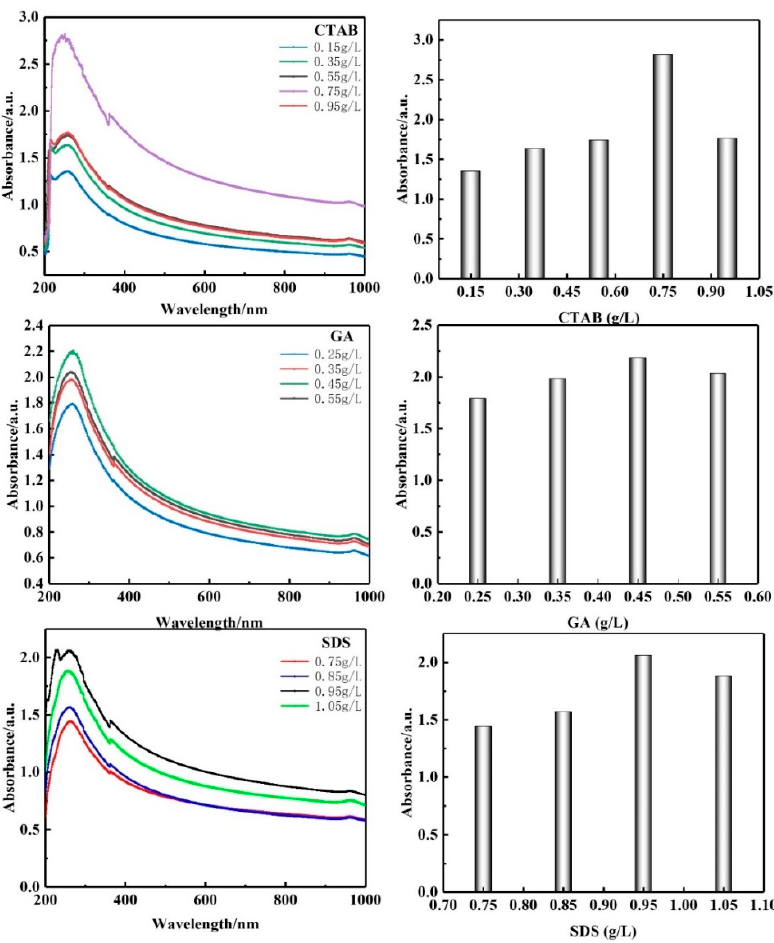
Figure 1. UV spectra of CNT dispersions and absorbance of CNT dispersions.